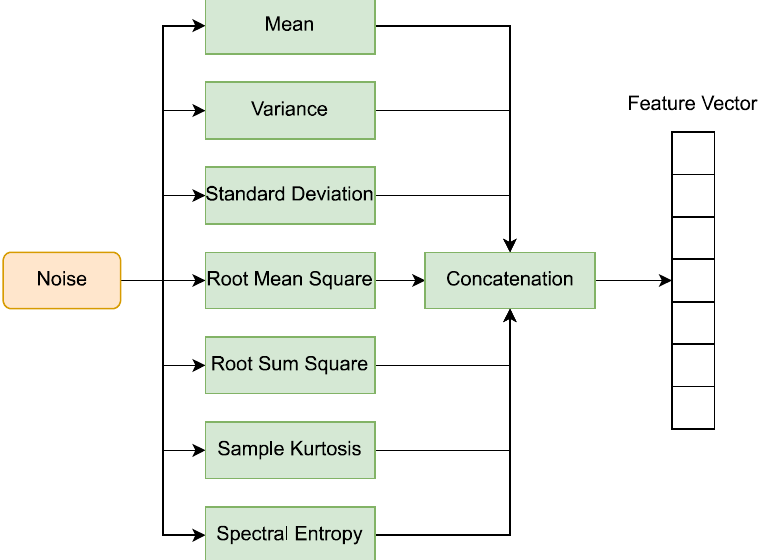
Figure 6. Feature extraction process.